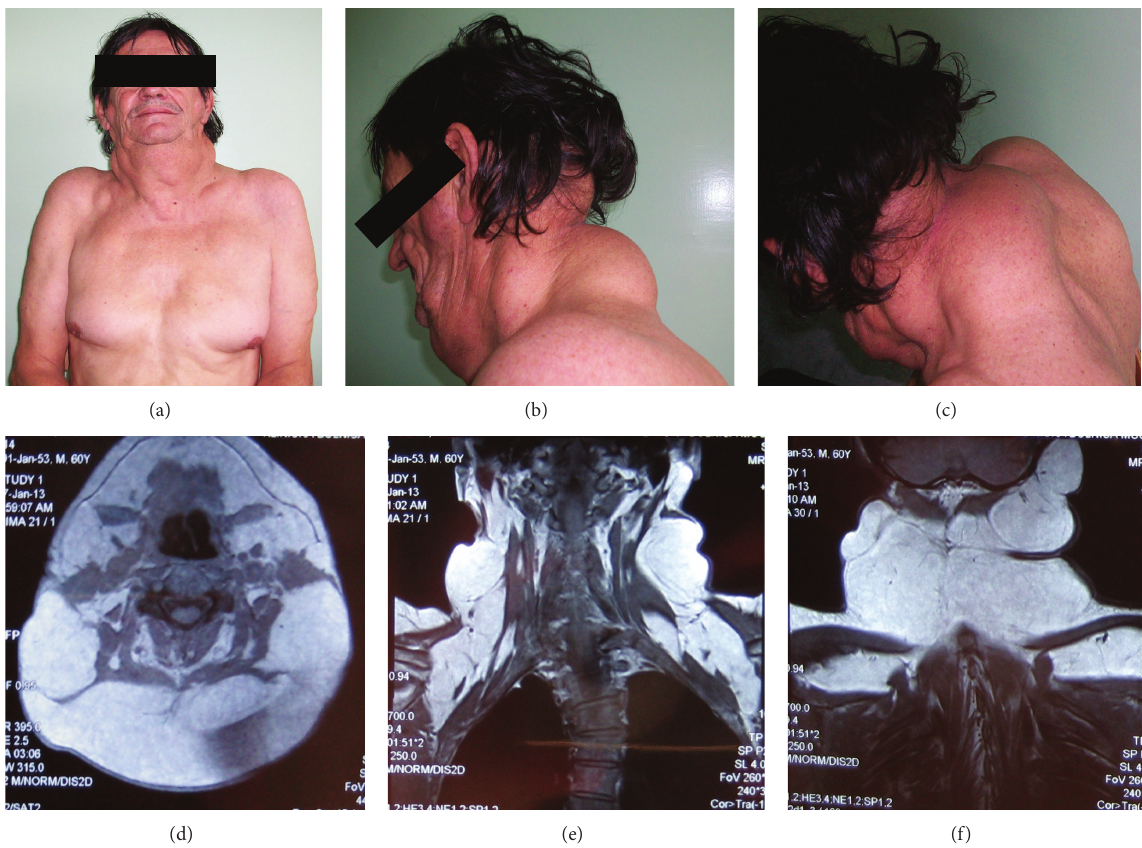
Figure 1: Picture of the patient showing Madelung’s disease with symmetric accumulation of lipomatous tissue in the cervical region. The most prominent enlargement was found in the retroauricular, occipital, and upper back areas ((a)–(c)). A cervicothoracic magnetic resonance imaging of the neck showing bilateral subcutaneous masses of nonencapsulated adipose tissue in ventral and lateral regions of the neck ((d)–